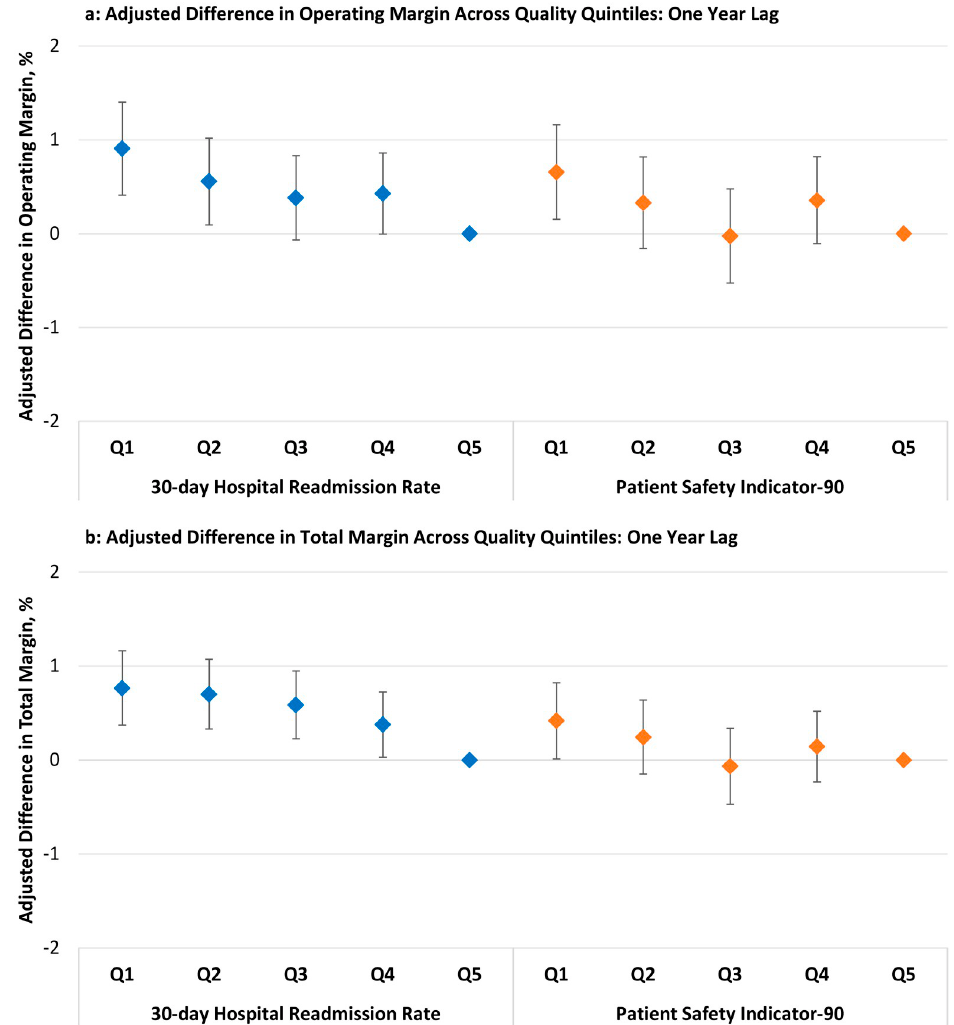
Fig 2. Adjusted difference in operating and total margin across quality quintiles: One year lag. Hospitals within the lowest previous year’s 30-day hospital-wide readmission rate quintile and hospitals within the lowest previous year’s PSI-90 score quintile experienced higher (a) operating margins and (b) total margins compared to their respective highest quality quintiles. Abbreviations: Q = quintile Vertical bars are the 95% confidence intervals. Q5 (worst) is the reference quintile. 30-day Readmission Rates (median): Q1 = 14.6, Q2 = 15.1, Q3 = 15.3, Q4 = 15.6, Q5 = 16.3 Patient Safety Indicator-90 (median): Q1 = 0.75, Q2 = 0.85, Q3 = 0.91, Q4 = 0.96, Q5 = 1.08 For readmission rates and PSI-90 scores, higher values represent lower